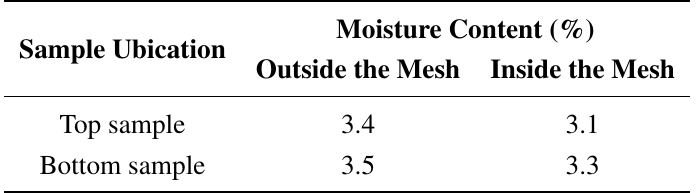
Table 2. Distribution of moisture in a test specimen along its height.